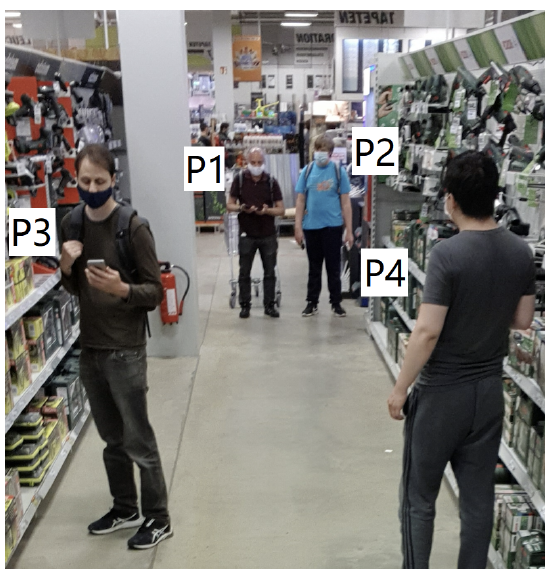
Figure 8. Places where data were collected.